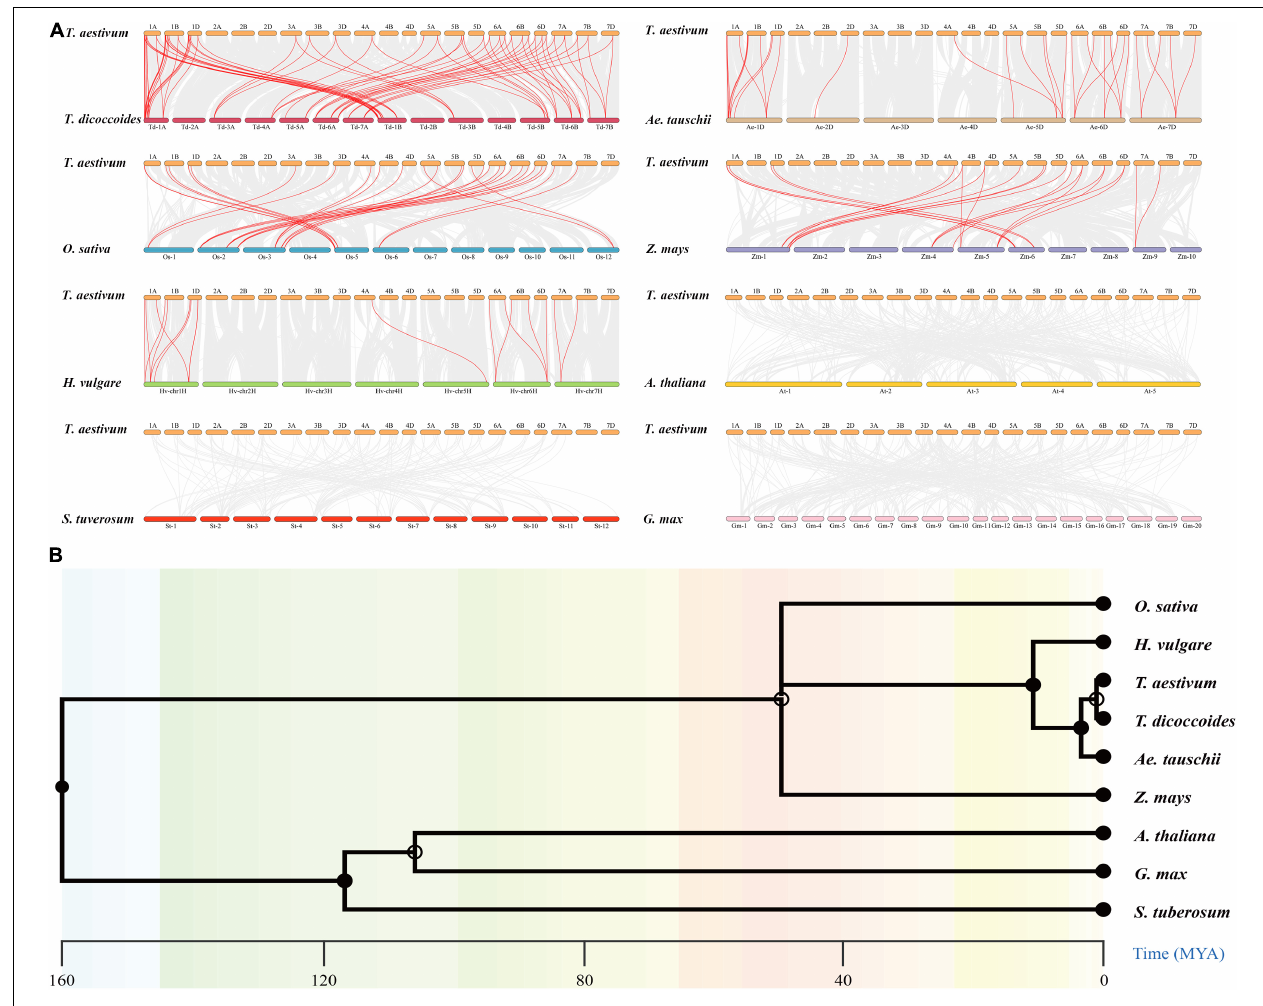
FIGURE 6 | Synteny analyses of the CCHC-ZFP family between wheat and other species. (A) Collinearity analysis of the TaCCHC-ZFP family with other eight representative species. The gray lines in the background represent the collinear blocks in the genome of wheat and other species, while the red lines indicate the syntenic CCHC-ZFP gene pairs. (B) Species evolution tree of wheat and other eight